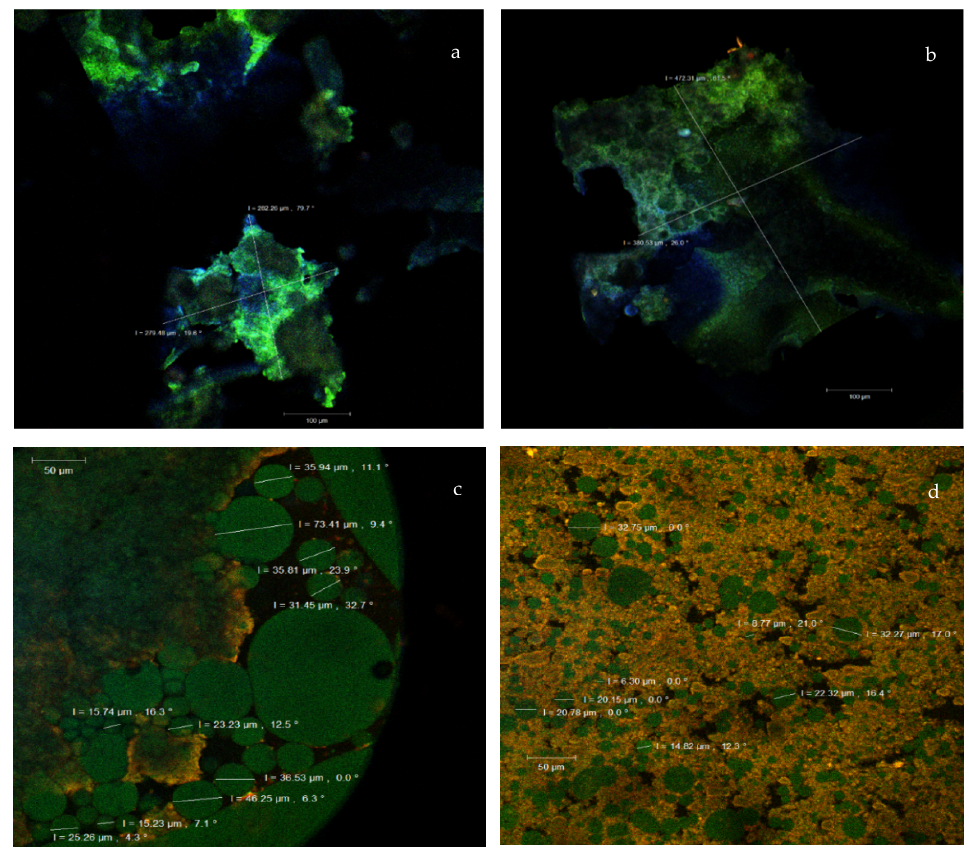
Figure 3. The confocal laser scanning microscopy (CLSM) images of the unstained powders native (N) ( a ) and transglutaminase (TG) ( b ) and the fluorophore dyed powders N ( c ) and TG ( d